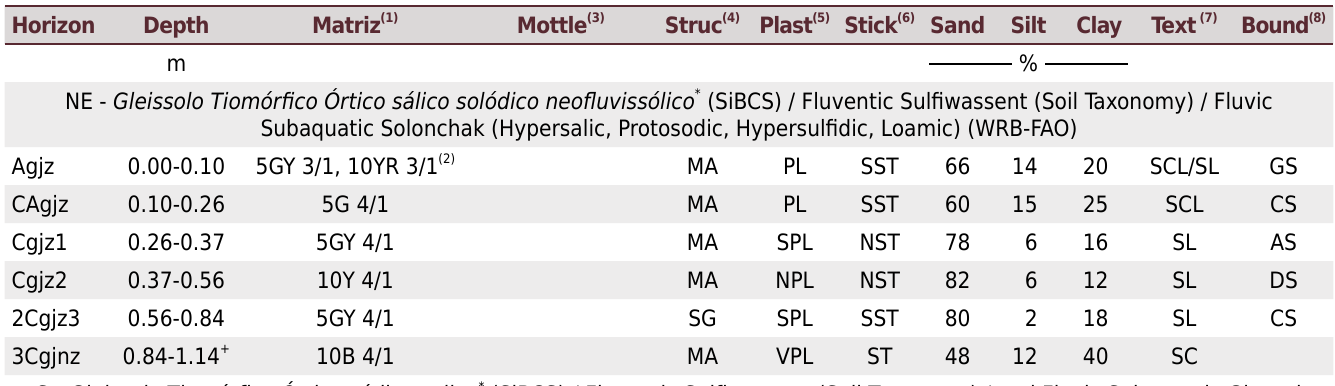
Table 1. Morphological properties and grain size composition of subaqueous soils of Brazilian seagrass meadows Horizon